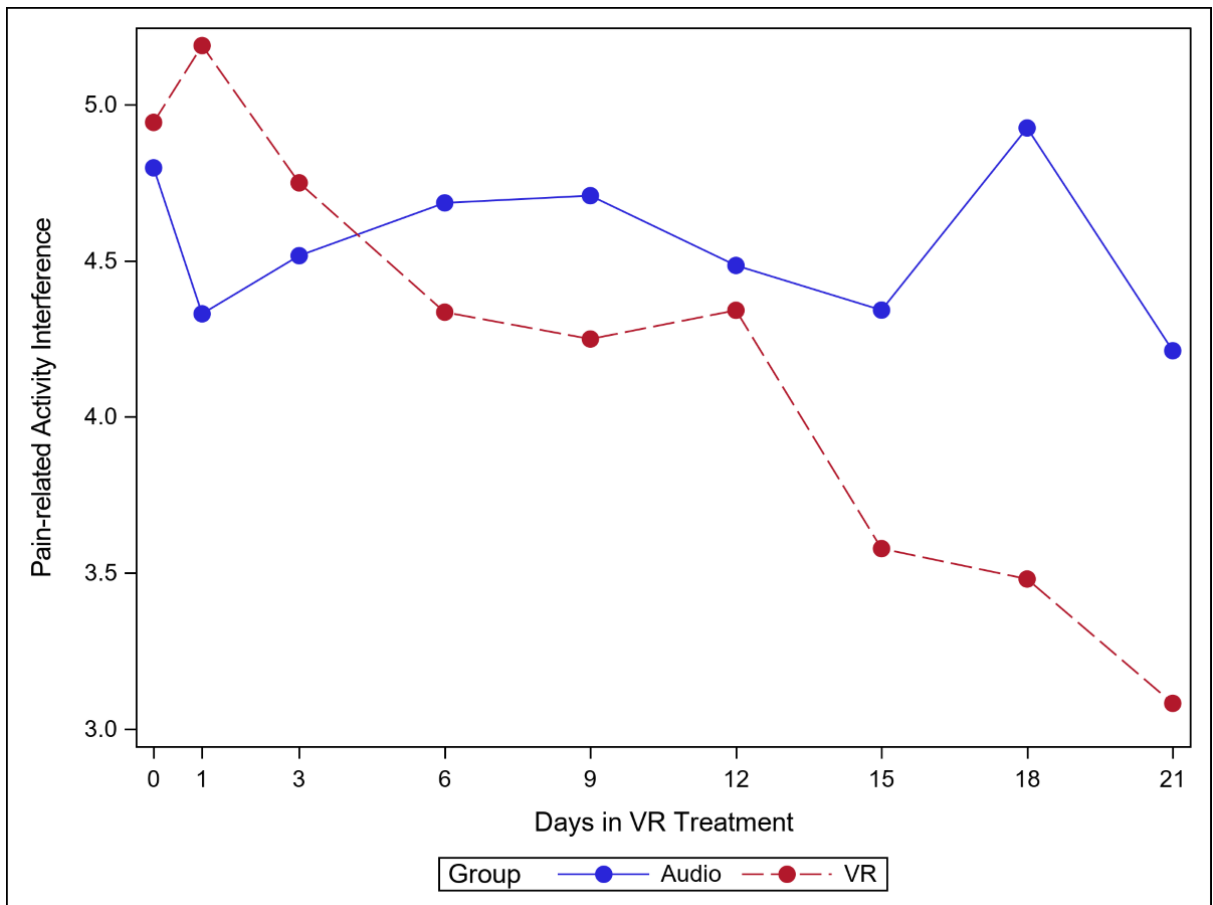
Figure 5. Effect of virtual reality vs audio on pain-related activity interference over